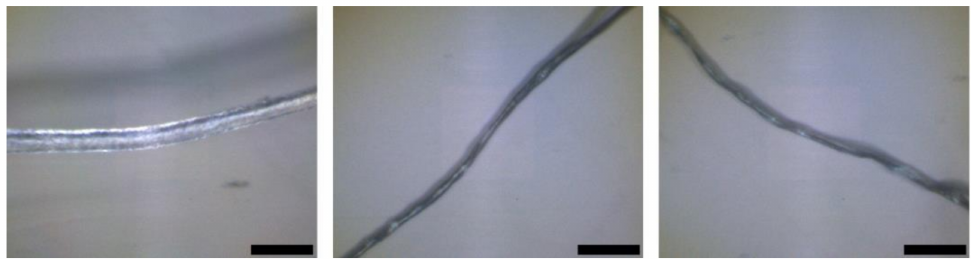
Figure 5. Images of a representative fiber mixture analyzed with an FTIR